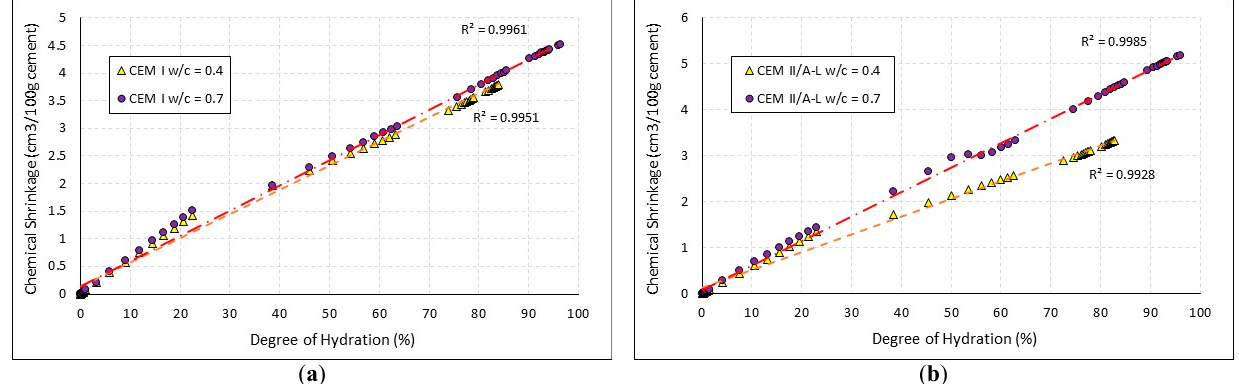
Figure 3. Predicted chemical shrinkage over time for the ( a ) CEM I and ( b ) CEM II/A-L cements and ( c ) a comparison of both.